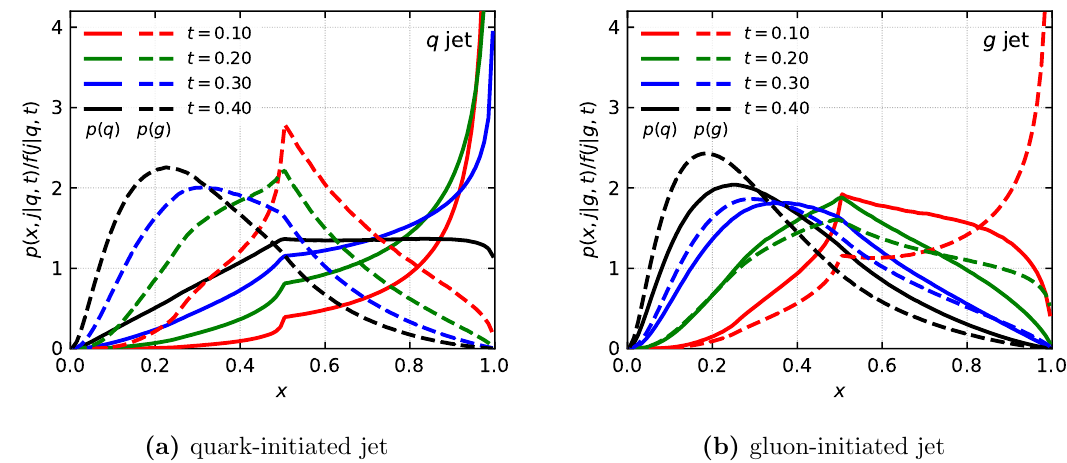
Figure 1. Distributions p ( x; j j i; t coll ) =f ( j j i; t coll ), with f ( j j i; t coll ) the average fraction of partons of (cid:13)avour j after a time t coll starting from a (cid:13)avour i (cf. eq. (3.12)), for di(cid:11)erent values of t coll as a function of x . The left (right) plot corresponds to quark (gluon)-initiated jets. On both plots, the solid (dashed) lines correspond to a quark (gluon) leading